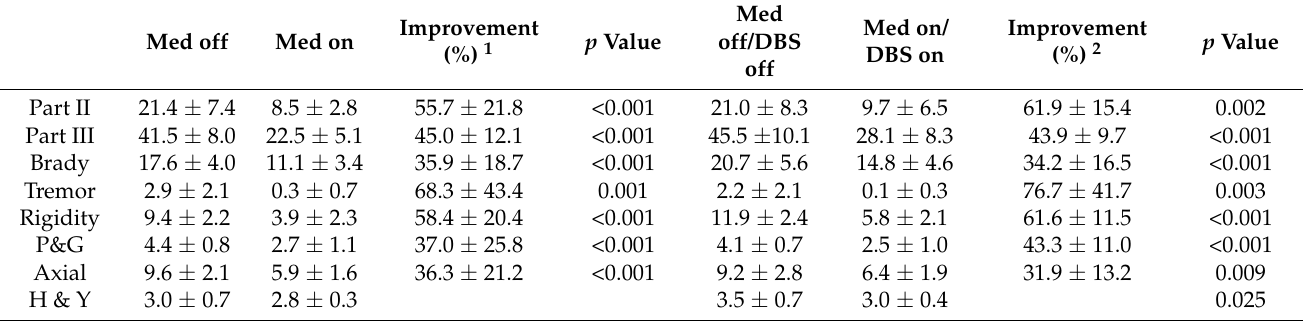
Table 2. Pre-operative improvement from medication and post-operative medication; deep brain stimulation synergistic